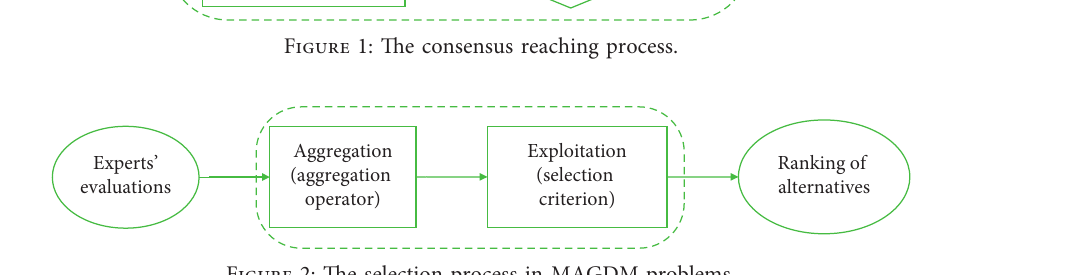
Figure 2: The selection process in MAGDM